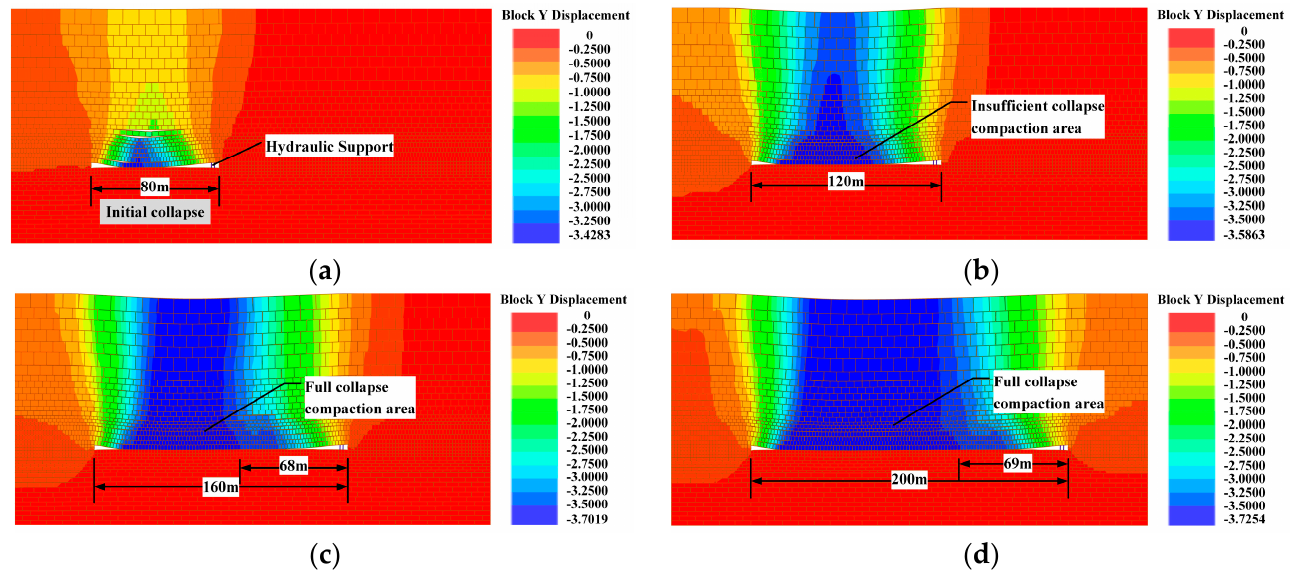
Figure 10. Displacement cloud image before cutting top: ( a ) is the displacement state when the working face is first broken when the top is not cut; ( b ) is the displacement state when the working face is excavated for 120 m when the top is not cut; ( c ) is the displacement state when the working face is excavated for 160 m when the top is not cut; and ( d ) is the displacement state when the working face is excavated for 200 m when the top is not cut.